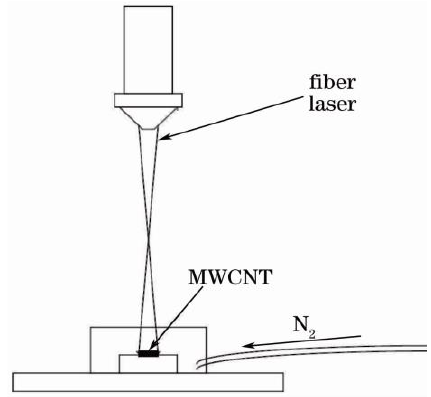
Figure 6. The setup of MWCNT samples irradiated by fiber laser.